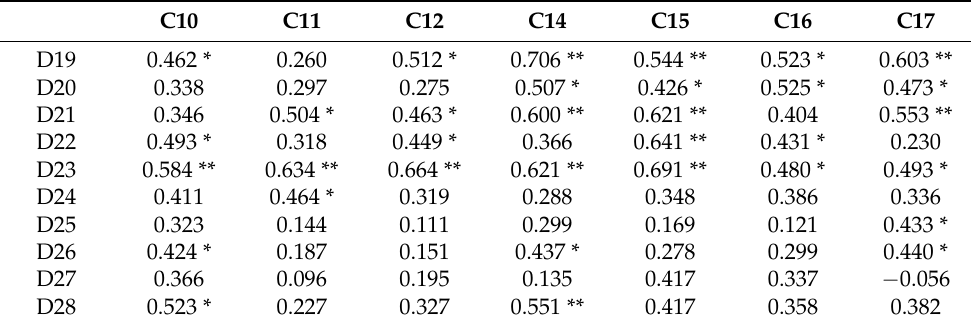
Table 4. Spearman correlation analysis between personnel and